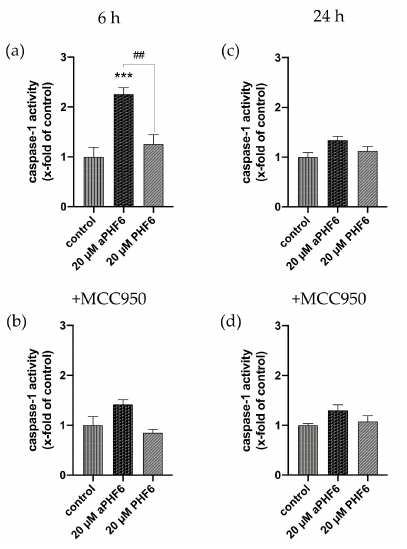
Figure 5. Elevated caspase-1 activity is mediated by NLRP3 after 6 h. ( a ) The determination of caspase-1 (CASP1) activity showcased an increase after 6 h of aPHF6 treatment, which returned to basal levels after 24 h ( b ). ( c ) Using the specific NLRP3 inhibitor, MCC950 revealed that the CASP1 activity was mainly driven by NLRP3 after 6 h. ( d ) At the prolonged stage, no differences were found in comparison to the control and the treatment without the inhibitor. ## p < 0.01, *** p < 0.001.